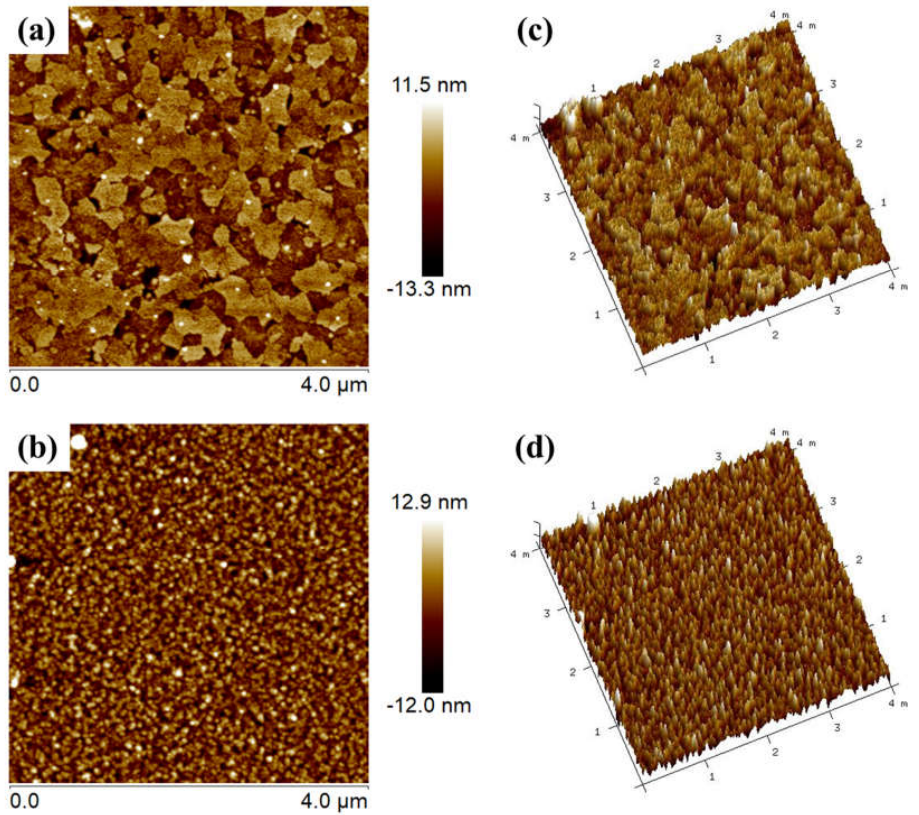
Figure 7. ( a , b ) show the 2D atomic force micrographs of the ITO and thermally deposited Al anode surface, respectively; ( c , d ) show their respective 3D micrograps.